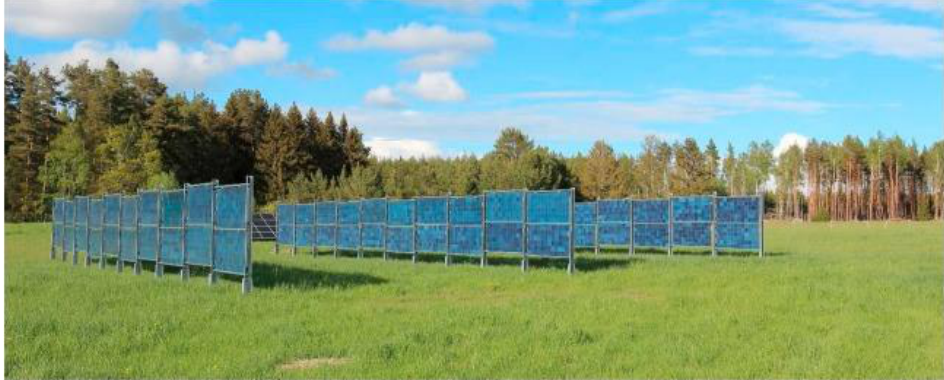
Figure 6. Bifacial vertical installation in Västerås, Sweden. Source: [48].